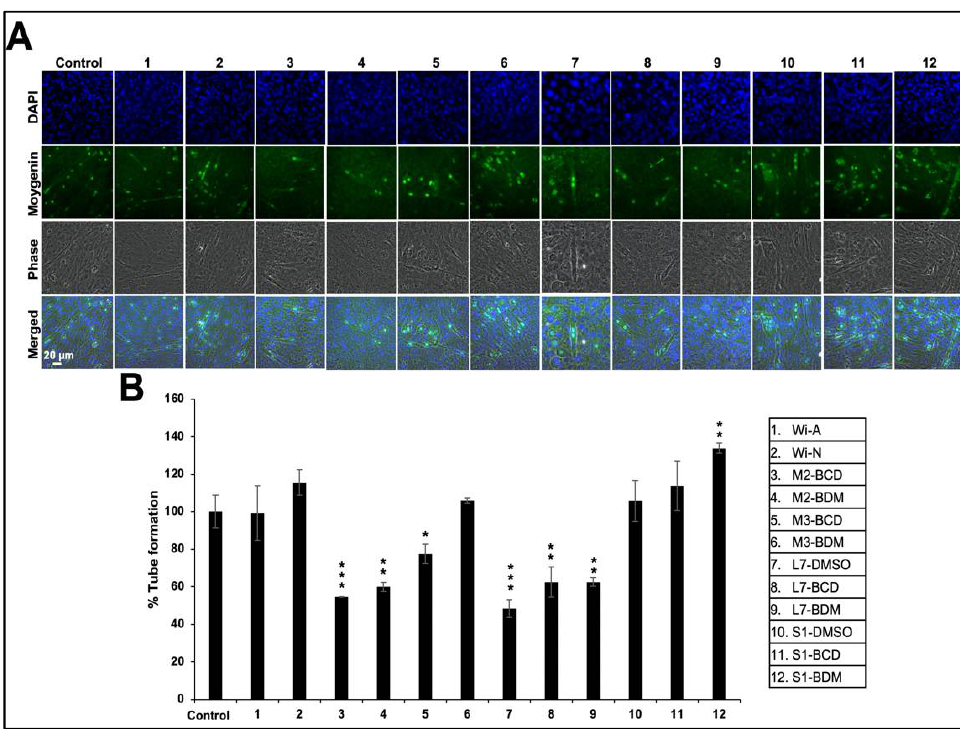
Figure 5. Induction of differentiation in response to Ashwagandha extracts and purified with- anolides. ( A ) Immunostaining for myogenin protein after incubation of Ashwagandha withanolides. ( B ) Quantitation of the results is shown below (mean ± SD, n = 3), * p < 0.05, ** p < 0.01, *** p < 0.001 (Student’s t-test to control).